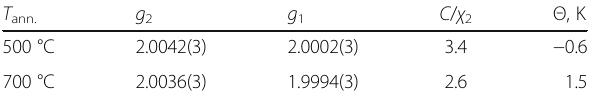
Table 2 Parameters of non-localized ( g 2 ) and localized ( g 1 ) paramagnetic systems extracted from the fitting of Eq. (2) with experimental data in annealed SiO 2 :C samples T